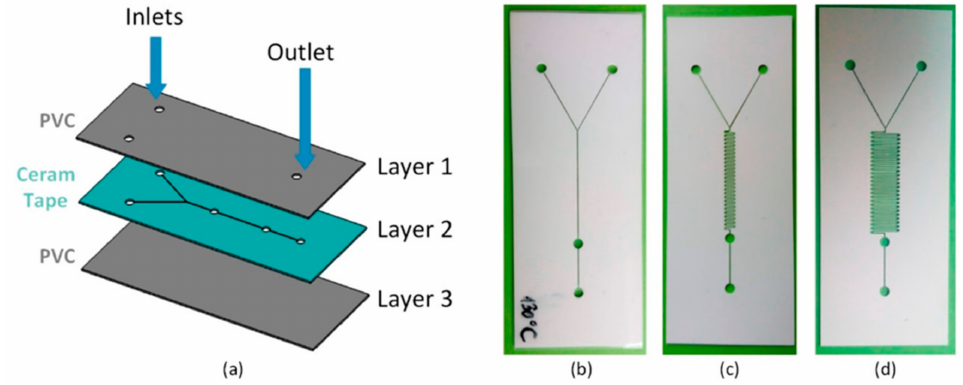
Figure 20. Microfluidic chips fabricated using the hybrid technology proposed by Kojic et al. ( a ) 3D model of the microfluidic chip (Layer1-PVC, Layer2-Ceram Tape, and Layer3-PVC), ( b ) simple channel, ( c ) short serpentine, and ( d ) long serpentine. Reprinted from an open-access source